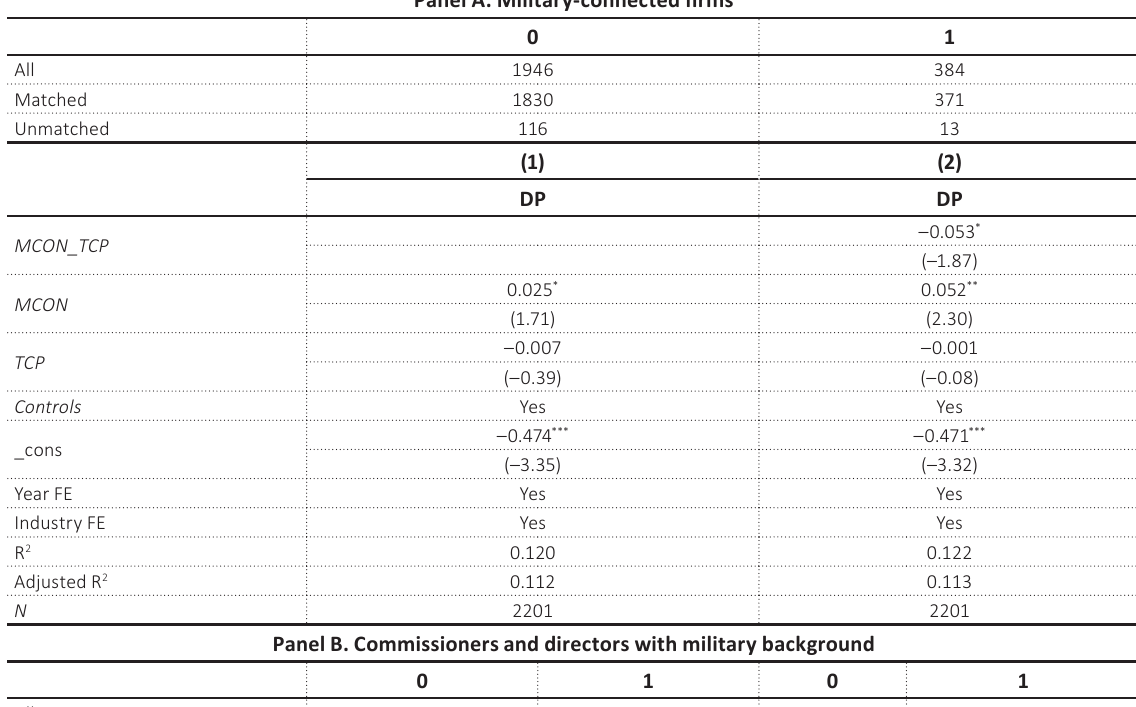
Table 7. CEM regression